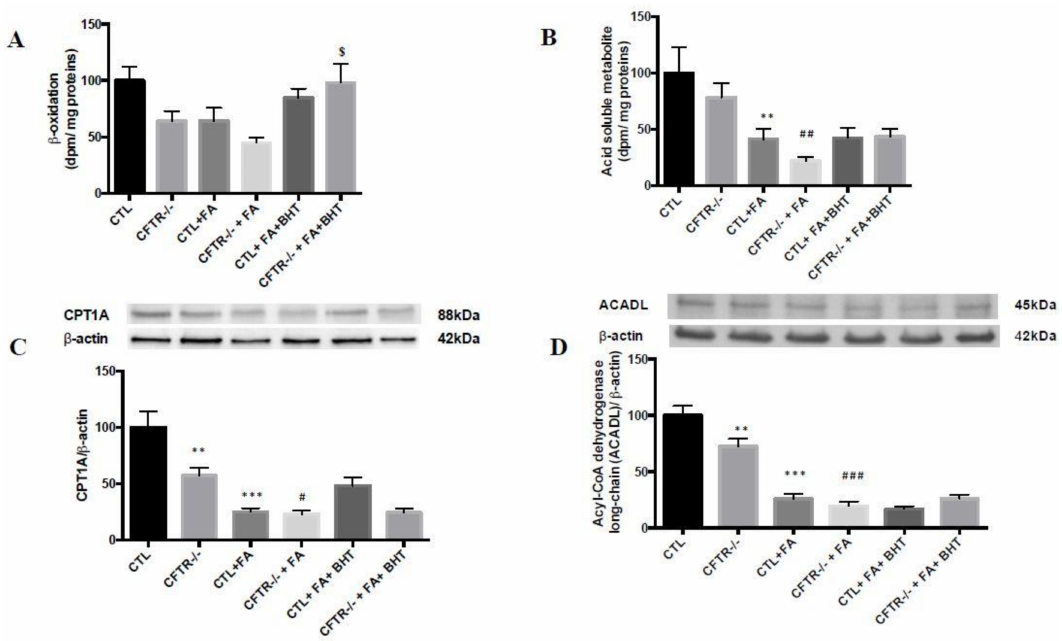
Figure 3. Influence of CFTR suppression on mitochondrial fatty acid β -oxidation and related regulatory enzymes. At the end of 15 days of differentiation, Caco-2/15 cells were harvested, trypsinized and resuspended. Thereafter, cells were incubated with palmitate. β -oxidation was monitored by quantification of ( A ) ( 14 C)-palmitate oxidized to ( 14 C)-CO 2 and ( 14 C)-acid-soluble products. ( B ) Complex II (CII). Mitochondrial protein mass of ( C ) carnitine palmitoyl transferase 1 A (CPT1A) and ( D ) acyl-coA dehydrogenase long chain (ACADL) was analyzed by western blotting. Values are means ± SEM of 3 independent experiments, each performed in triplicate. ** p < 0.01, *** p < 0.001 vs. CTL cells; # p < 0.05, ## p < 0.01, ### p < 0.001 vs. CFTR -/- cells; $ p < 0.05 vs. CFTR -/- + FA cells. CTR: control cells; FA: iron/ascorbate (200 µ M/0.5 mM); BHT: Butylated hydroxy toluene (0.5